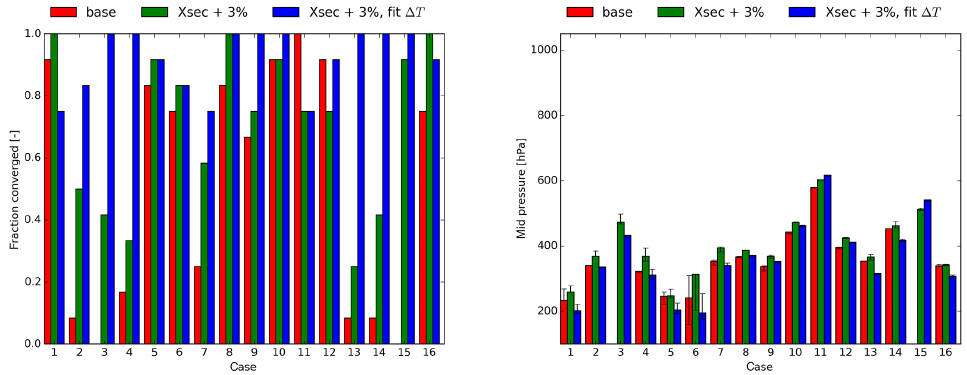
Figure 13. Fraction of converged runs (left) and retrieved aerosol layer mid pressure (right) for 16 GOME-2A target pixels and three experimental conditions. In the third experimental condition, the oxygen absorption cross section is increased by 3% and a temperature offset is fitted. This condition corresponds to the default retrieval setup used for the scene retrievals of Sect. 7. In the second experimental condition, only the oxygen absorption cross section is scaled, but the temperature profile is fixed in retrieval. In the first experimental condition, neither the oxygen absorption cross section is scaled nor a temperature offset is fitted. All other details of the retrieval setup are the same as in Sect. 7 and the surface albedo is fitted (as in Fig.